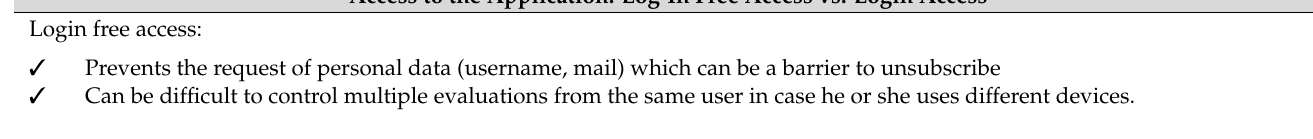
Table 1. Main themes and ideas related with the content of the